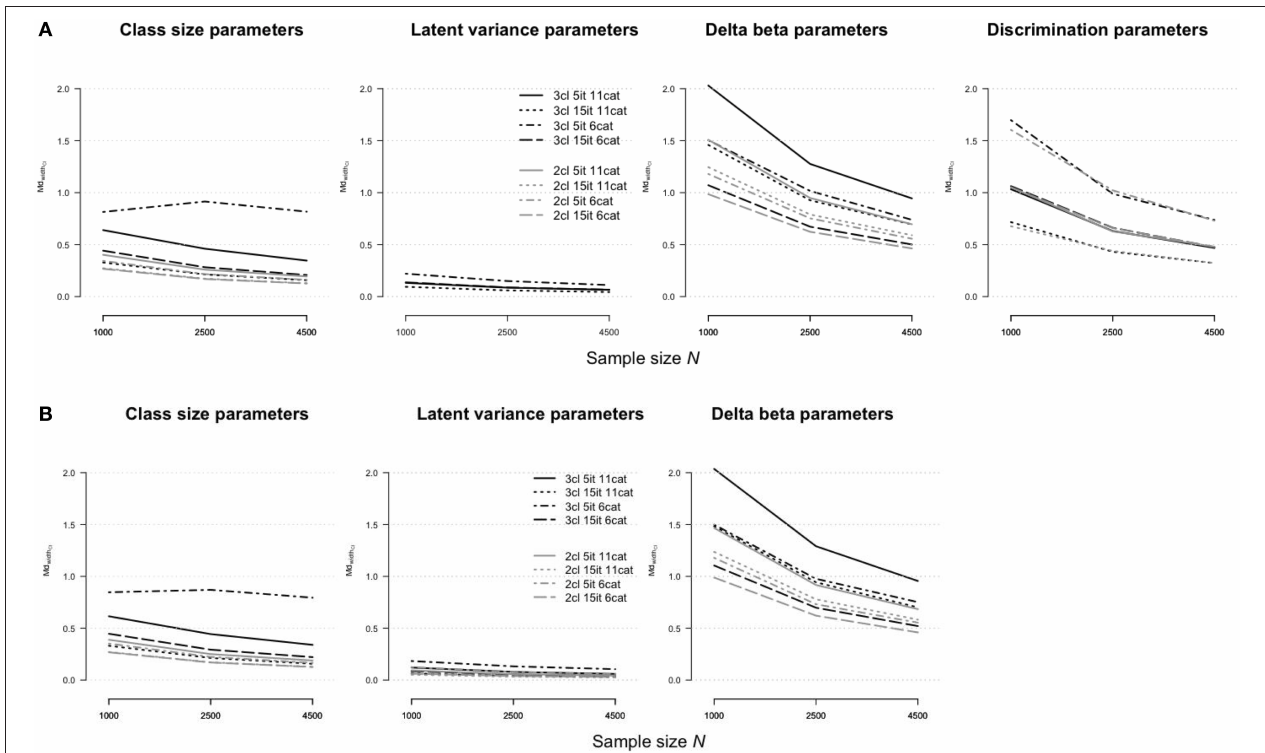
FIGURE 6 | Width of confidence interval for parameter estimates in (A) the rmGPCM-3 and (B) the mPCM-3 under further data conditions.